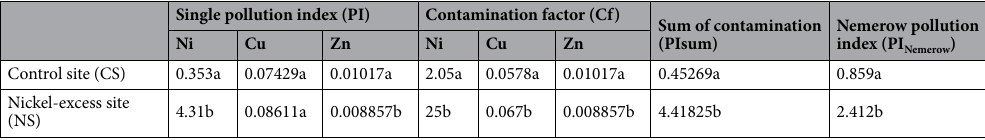
Ni uptake potential of liverworts. Asterella wallichiana and Plagiochasma appendiculatum grown in